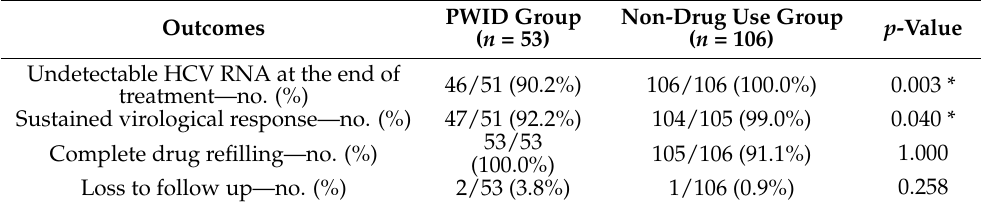
PWID Group ( n = 53)